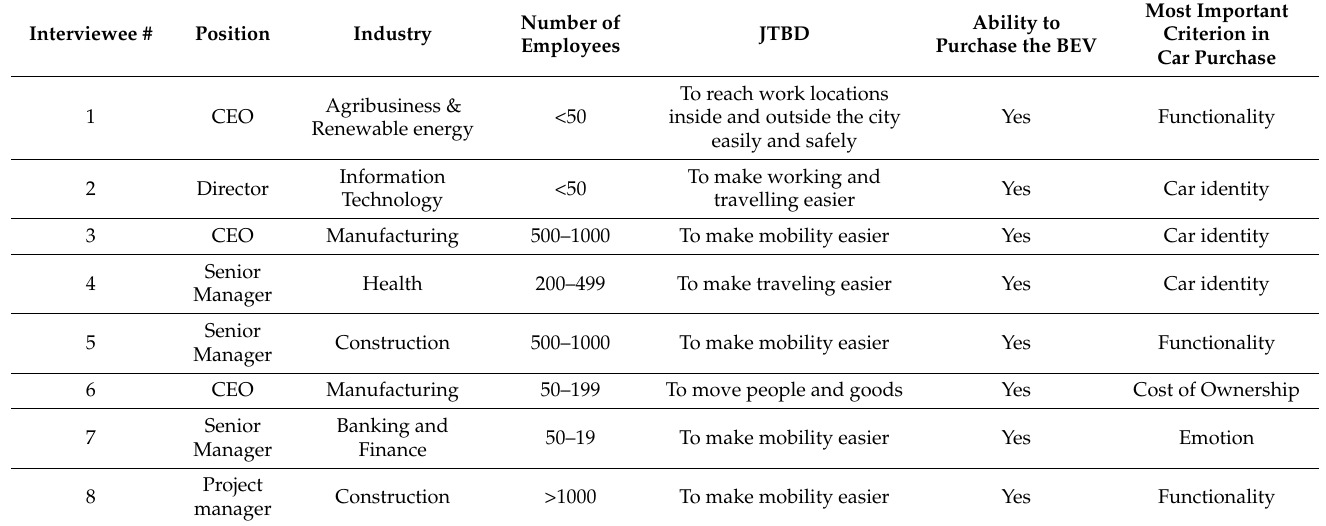
Table 2. List of Interviewees.